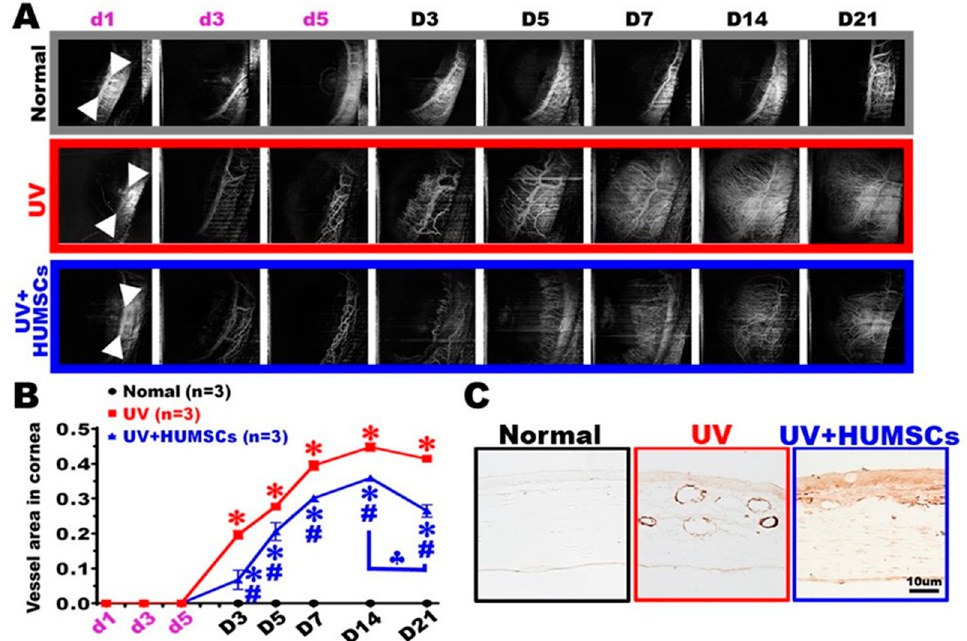
Figure 6. HUMSC transplantation diminishes angiogenesis after UV irradiation. Multifunction OCT shows the OCTA enface image ( A ) and analyzes the vessel area in the cornea ( B ). The vascular endothelial cells of the parietal peritoneum were labeled with a CD31 antibody. The results showed a large number of vessels in the stroma of the UV group. The number of blood vessels substantially decreased in the cornea of the UV + HUMSC group ( C ). * vs. the Normal group simultaneously, p < 0.05; # vs. the UV group at the same time, p < 0.05; ♣ vs. the UV + HUMSC group at day 14, p < 0.05.